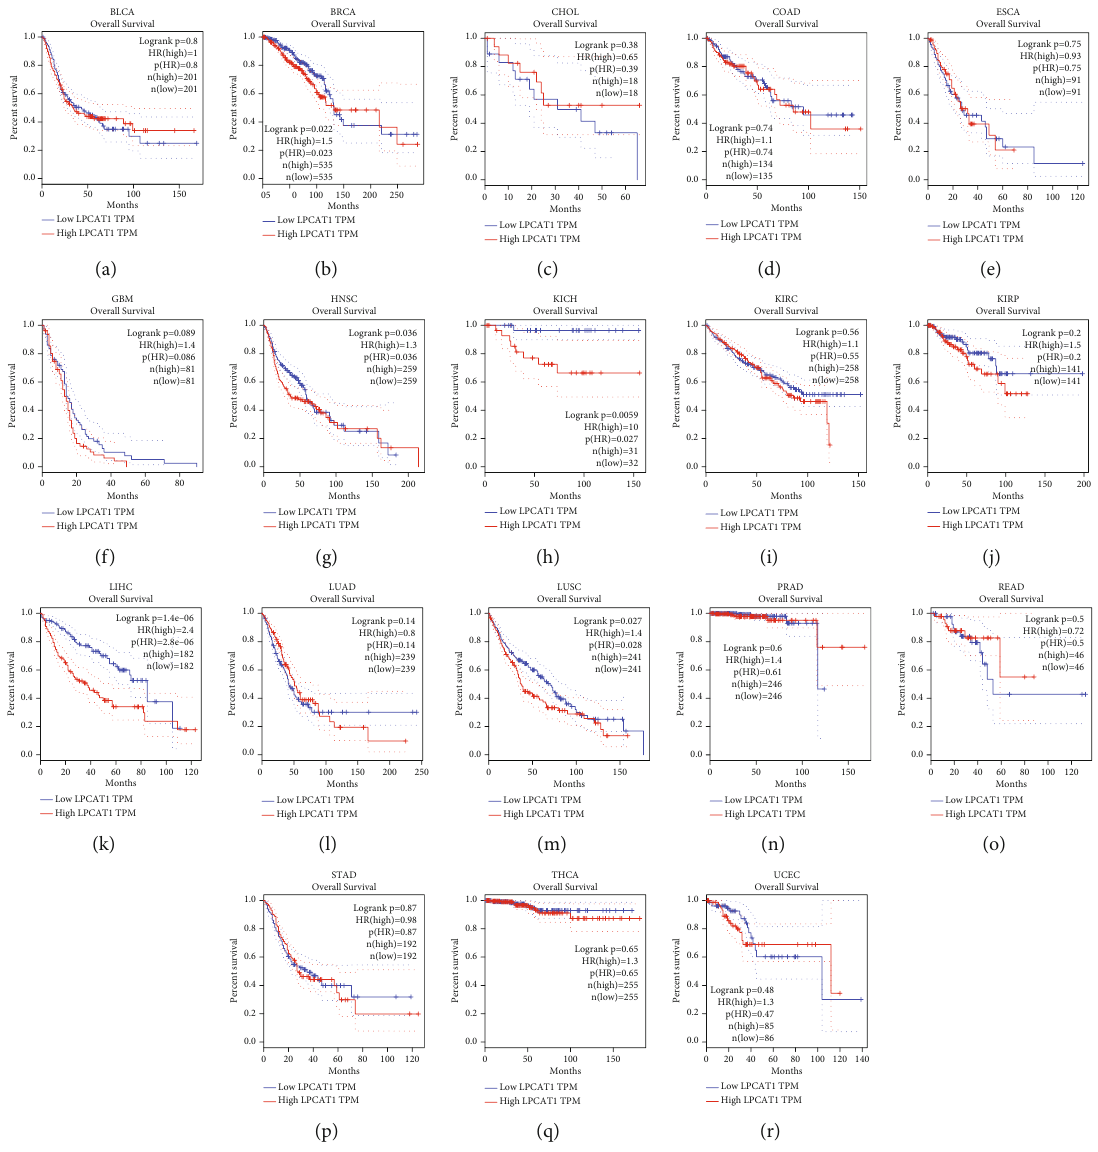
Figure 2: The overall survival (OS) analysis for LPCAT1 in various human cancers determined by the GEPIA database. (a) – (l) The OS plot of LPCAT1 in BLCA (a), BRCA (b), CHOL (c), COAD (d), ESCA (e), GBM (f), HNSC (g), KICH (h), KIRC (i), KIRP (j), LIHC (k), LUAD (l), LUSC (m), PRAD (n), READ (o), STAD (p), THCA (q), and UCEC